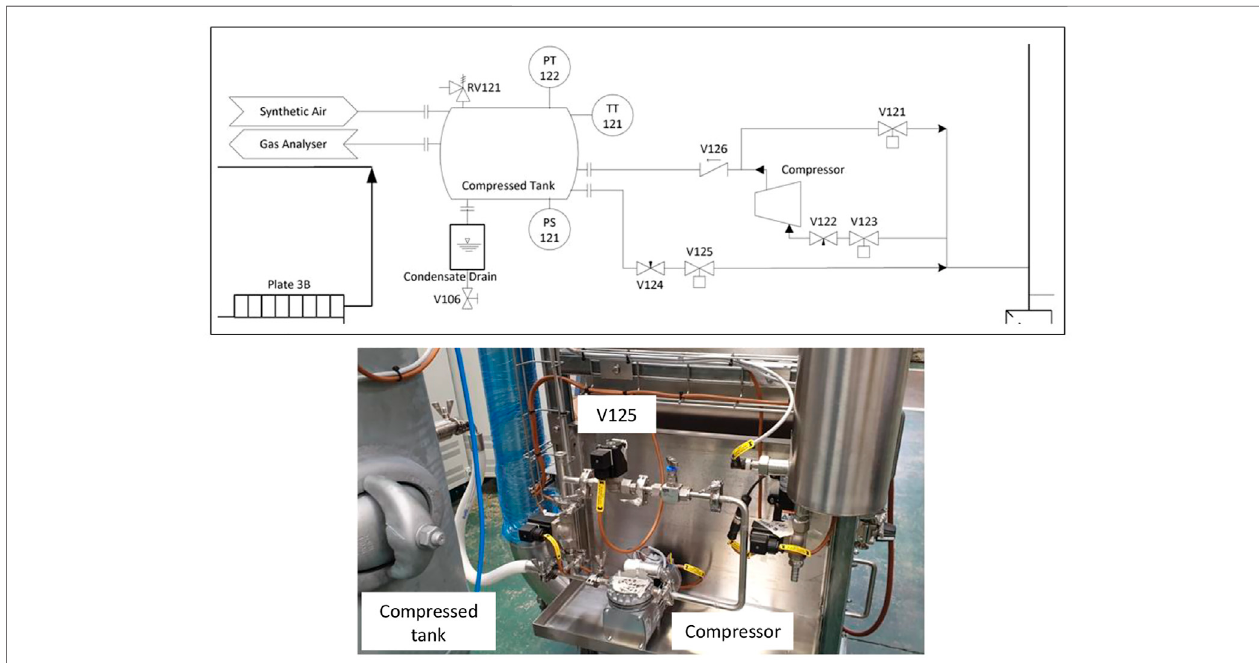
FIGURE 3 | Schematic view and picture of the pressure compensation system implemented in the PCU. The compressor extracts air from the chamber if the internalpressuremustbereducedandstoresitinthecompressedtank,whilewhenthepressurehastobeincreasedtheairstoredinthecompressedtankisre-injected by opening valve